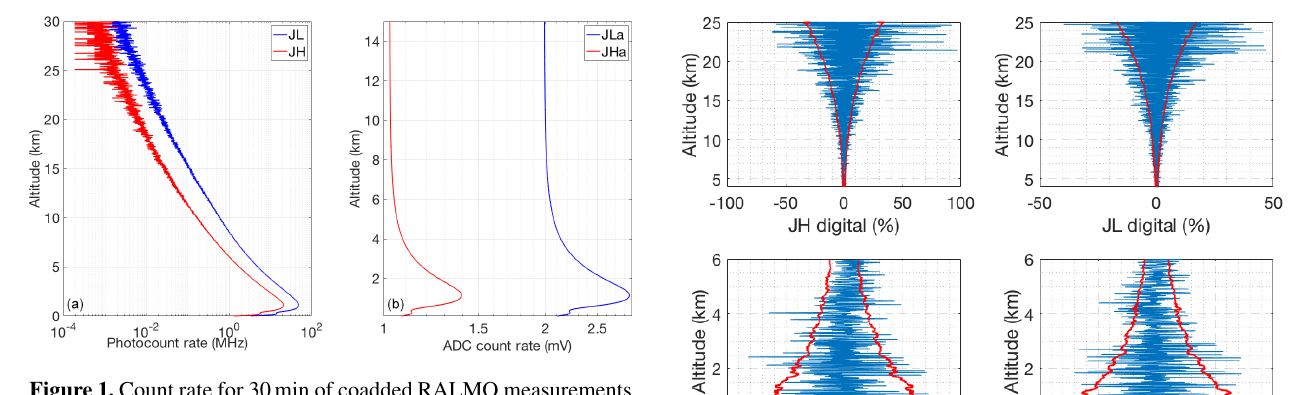
Figure 1. Count rate for 30min of coadded RALMO measurements from 23:00UT on 9 September 2011, a clear night; (a) Photon- counting channels (blue curve, JL; red curve, JH); (b) Analog chan- nels.